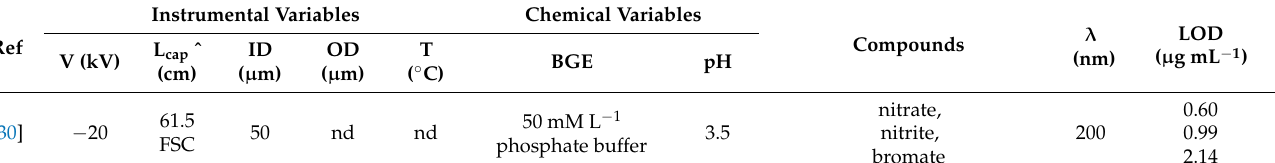
Table 2. Application of capillary electrophoresis with ultraviolet detection